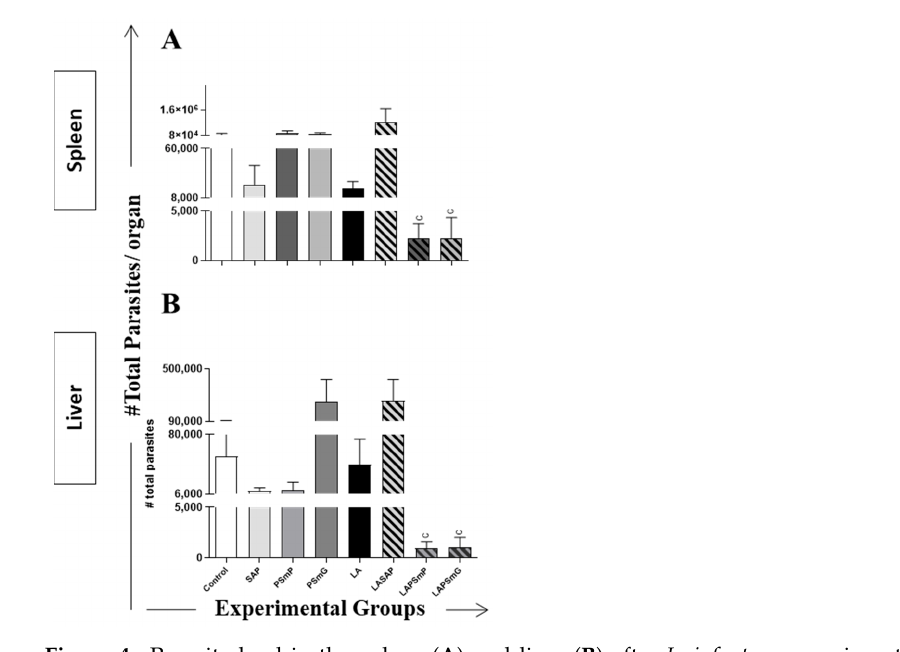
Figure 4. Parasite load in the spleen ( A ) and liver ( B ) after L . infantum experimental challenge, according to qPCR reaction. The x axis represents the experimental groups and the y axis represents the mean ± standard deviation of parasite quantification in 10 6 cells of each organ. The statistical difference ( p < 0.05), when present, was represented by the acronym of the corresponding group. Legend: C: control; SAP: saponin; PSmP: small empty submicron particle; PSmG: large empty submicron particle; LA: L . amazonensis crude antigen; LASAP: L . amazonensis crude antigen associated with saponin; LAPSmP: small submicron particle associated with L . amazonensis ; LAPSmG: large submicron particle associated with L . amazonensis .